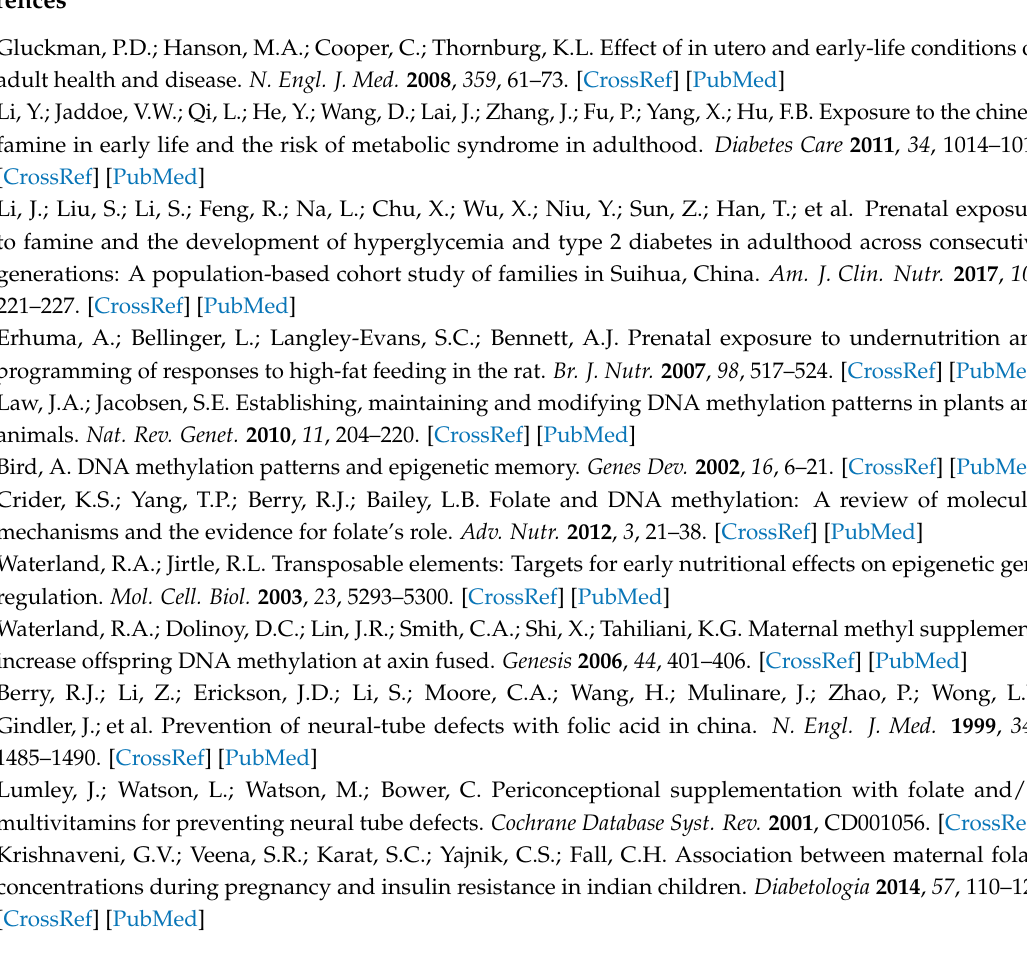
Table S1. Compositions of the diets; Table S2. mRNA primers of genes related to lipid metabolism; Table S3. Methylation primers of ATGL and LPL ; Figure S1. Schematic diagram of the CpG loci in ATGL and LPL ; Figure S2. Food intake of dams and pups in different groups. Values are means with standard deviations; Figure S3. Serum folic acid and homocysteine levels of dams at delivery. Values are means with standard deviations. * The difference between the two groups indicated by the line segment is significant, p < 0.05; Figure S4. Body weight changes of male offspring in different groups. Values are means with standard deviations. * The difference between CON-HF/FAS-HF and CON-CON/FAS-CON is significant, p <